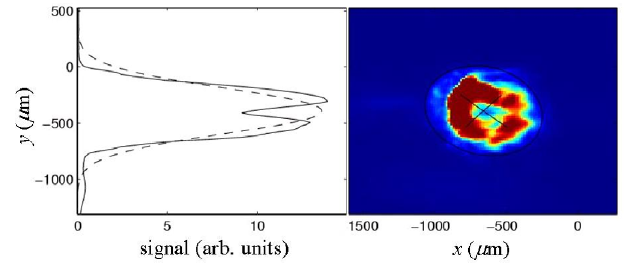
FIG. 43. (Color) An image of the COTR radiation after BC1 observed with extreme bunch compression.